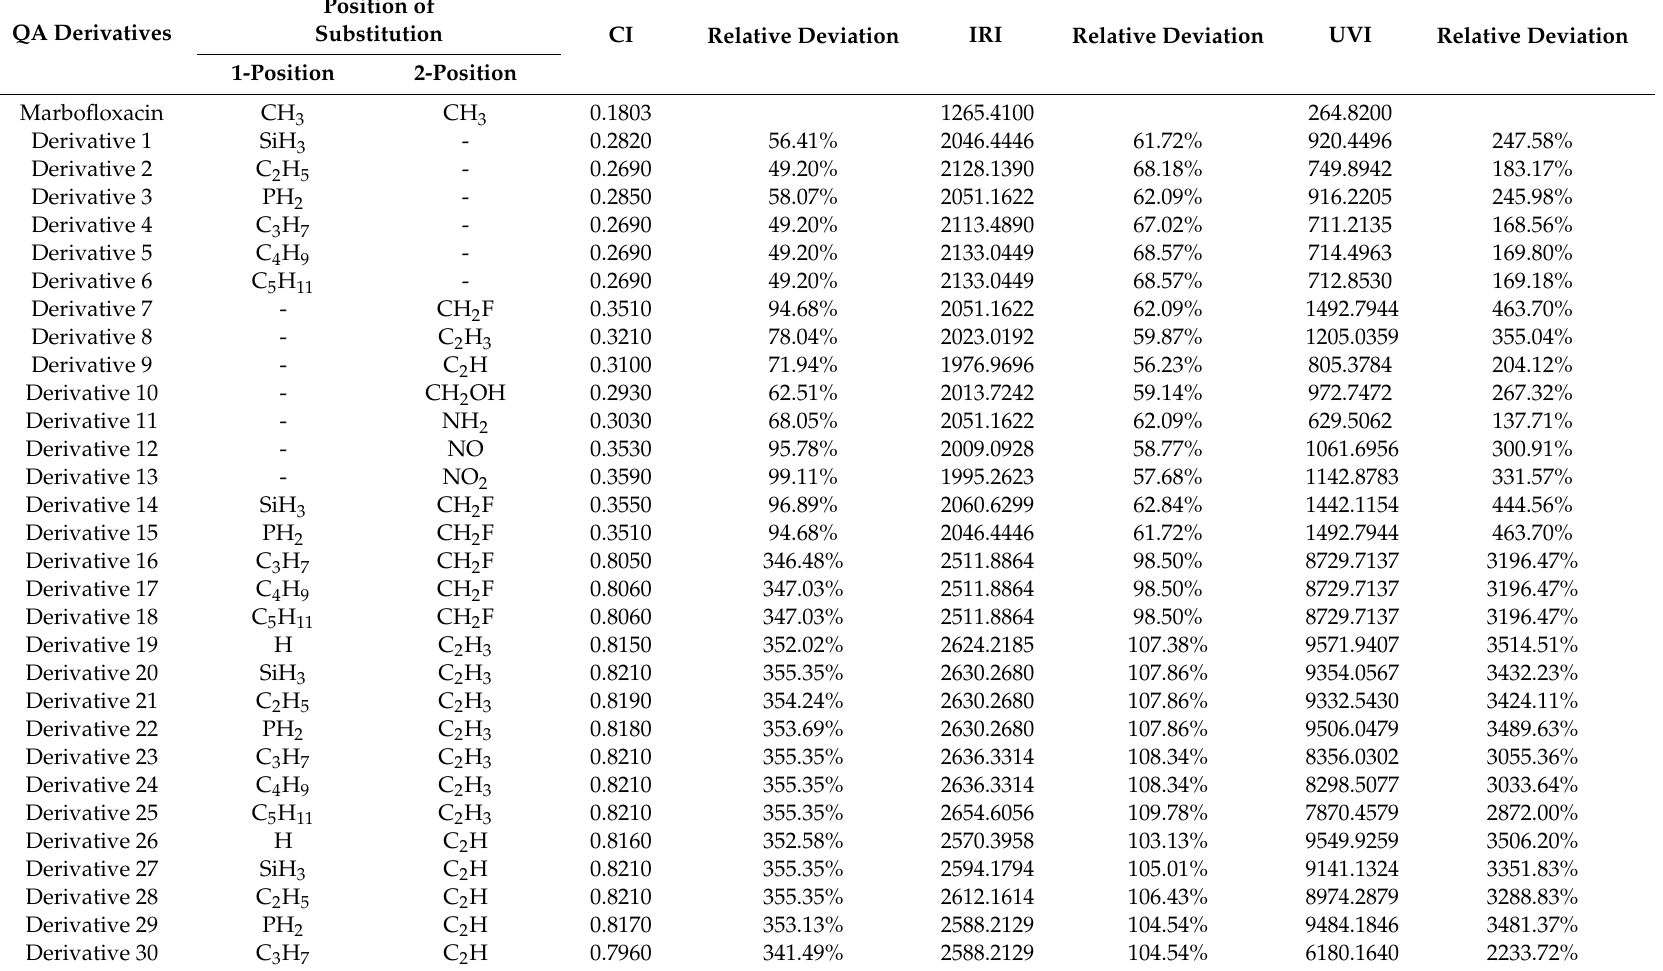
Table 6. The predicted evaluation of 87 QA derivatives’ molecular spectral